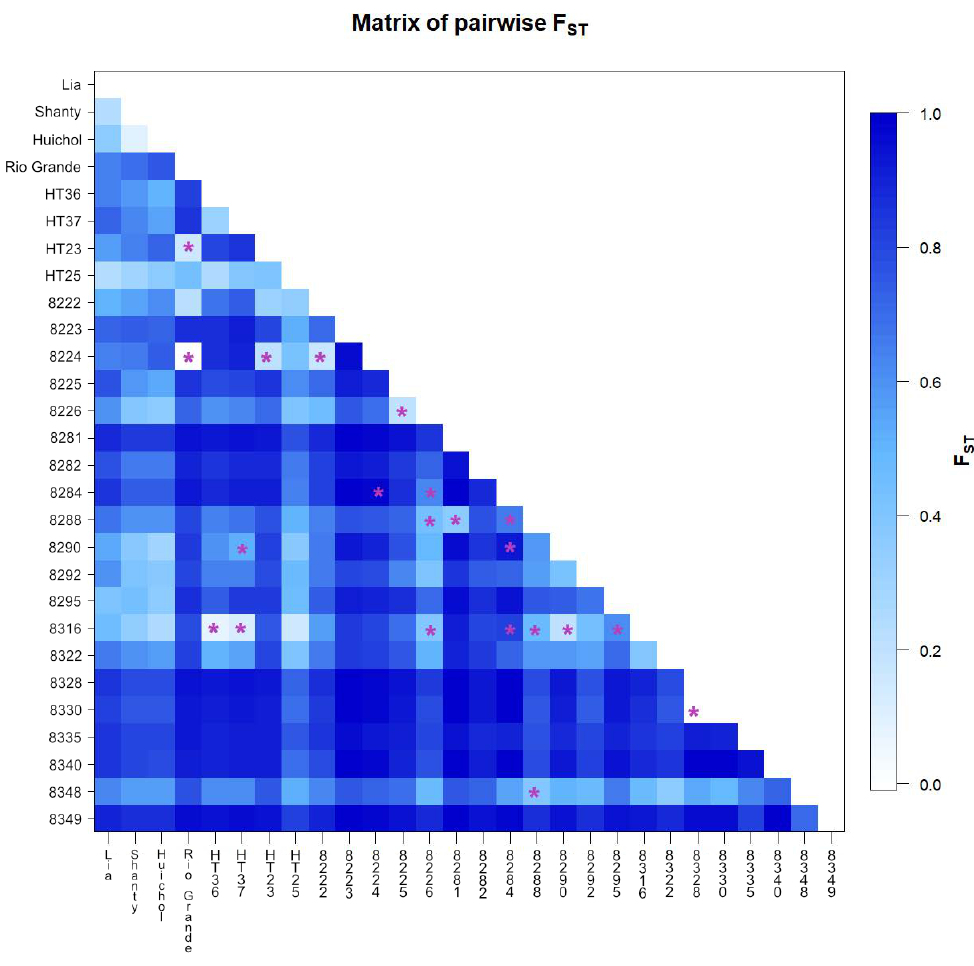
Figure 3. Heatmap of pairwise fixation index F ST of the 28 tomato accessions, calculated using the number of different alleles as a distance method. The differentiation between each pair of accessions was significant ( p < 0.05) except in the case of pairs marked with a purple asterisk. A heatmap of pairwise Nei’s distance (below diagonal in Figure 4) corroborated the low differentiation between most accessions except BOL-8281-HT, BOL-8284-HT,